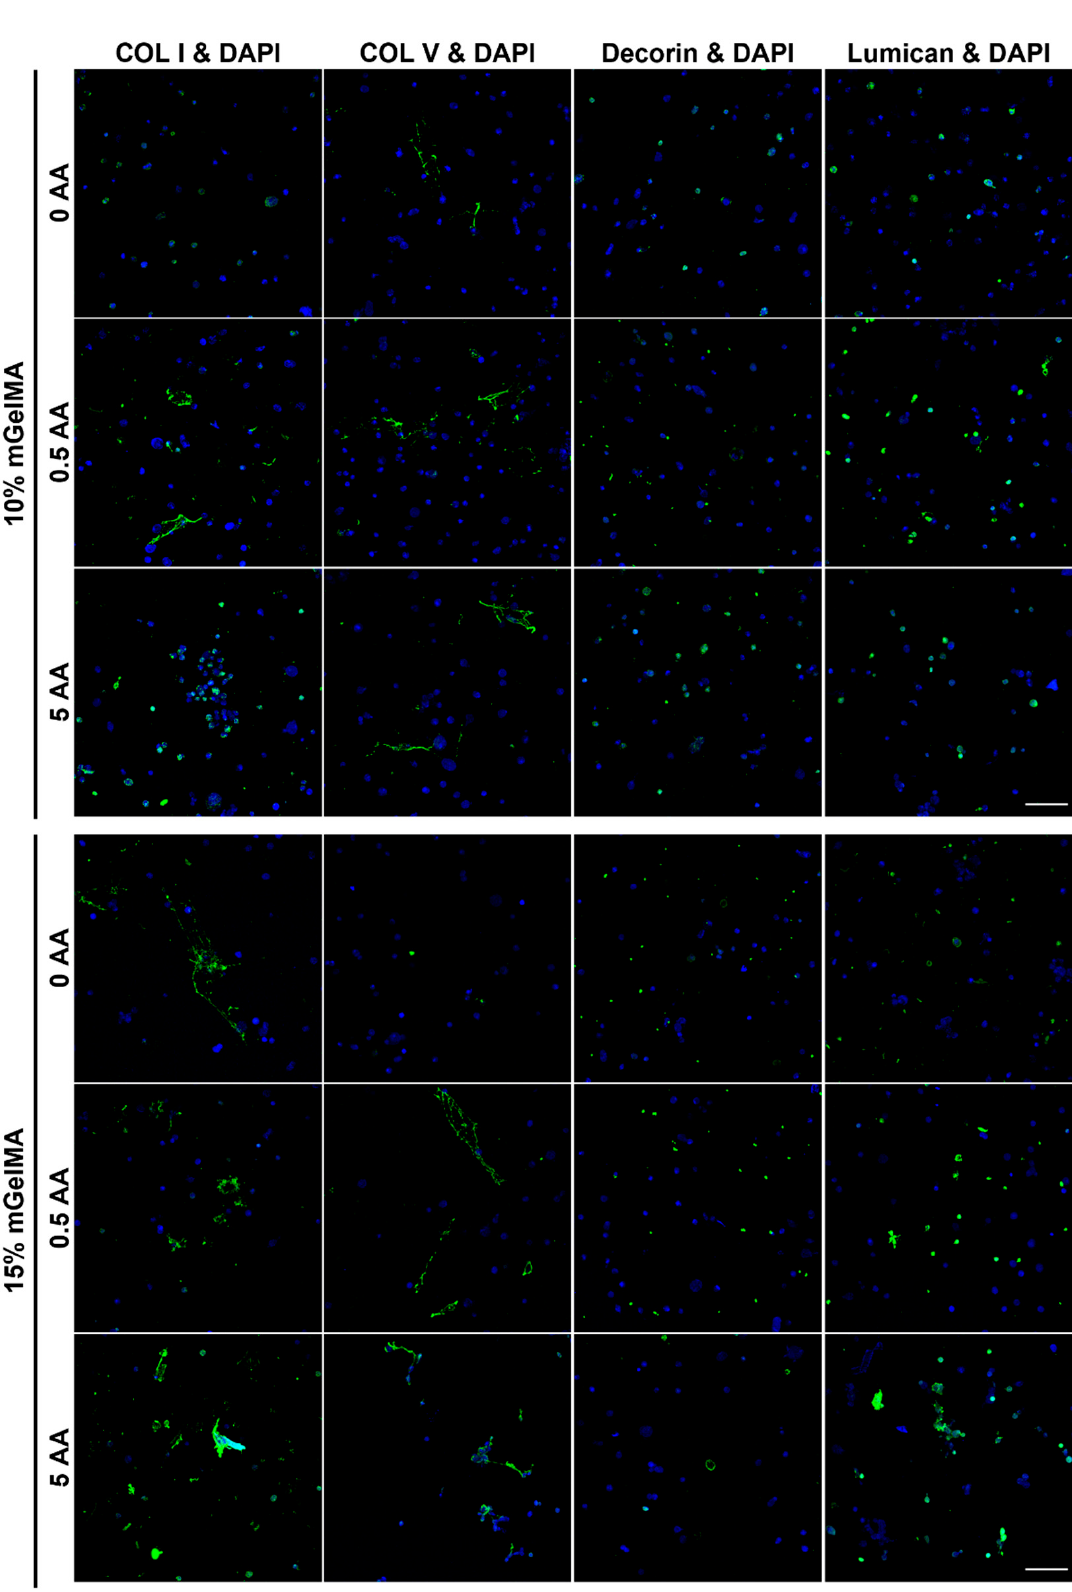
Figure 12. Immunofluorescence micrograph of mGelMA hydrogels at day 21 with collagen type I (COL I), collagen type V (COL V), decorin, and lumican, stained in green. Nuclei were visualized by staining with DAPI (blue). Scale bar are 100 µm.